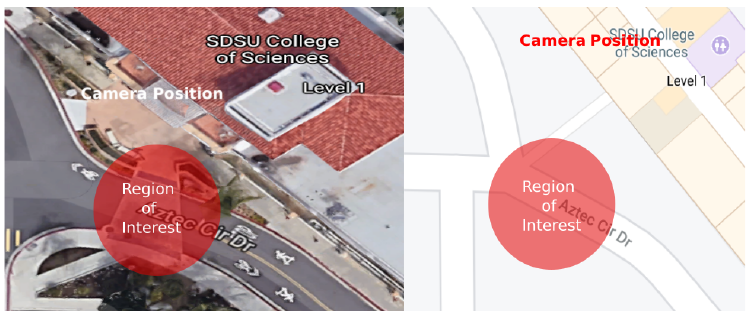
Figure 3. Region of Interest for Conflict Zone Analysis and Automated Computation of PET at San Diego State